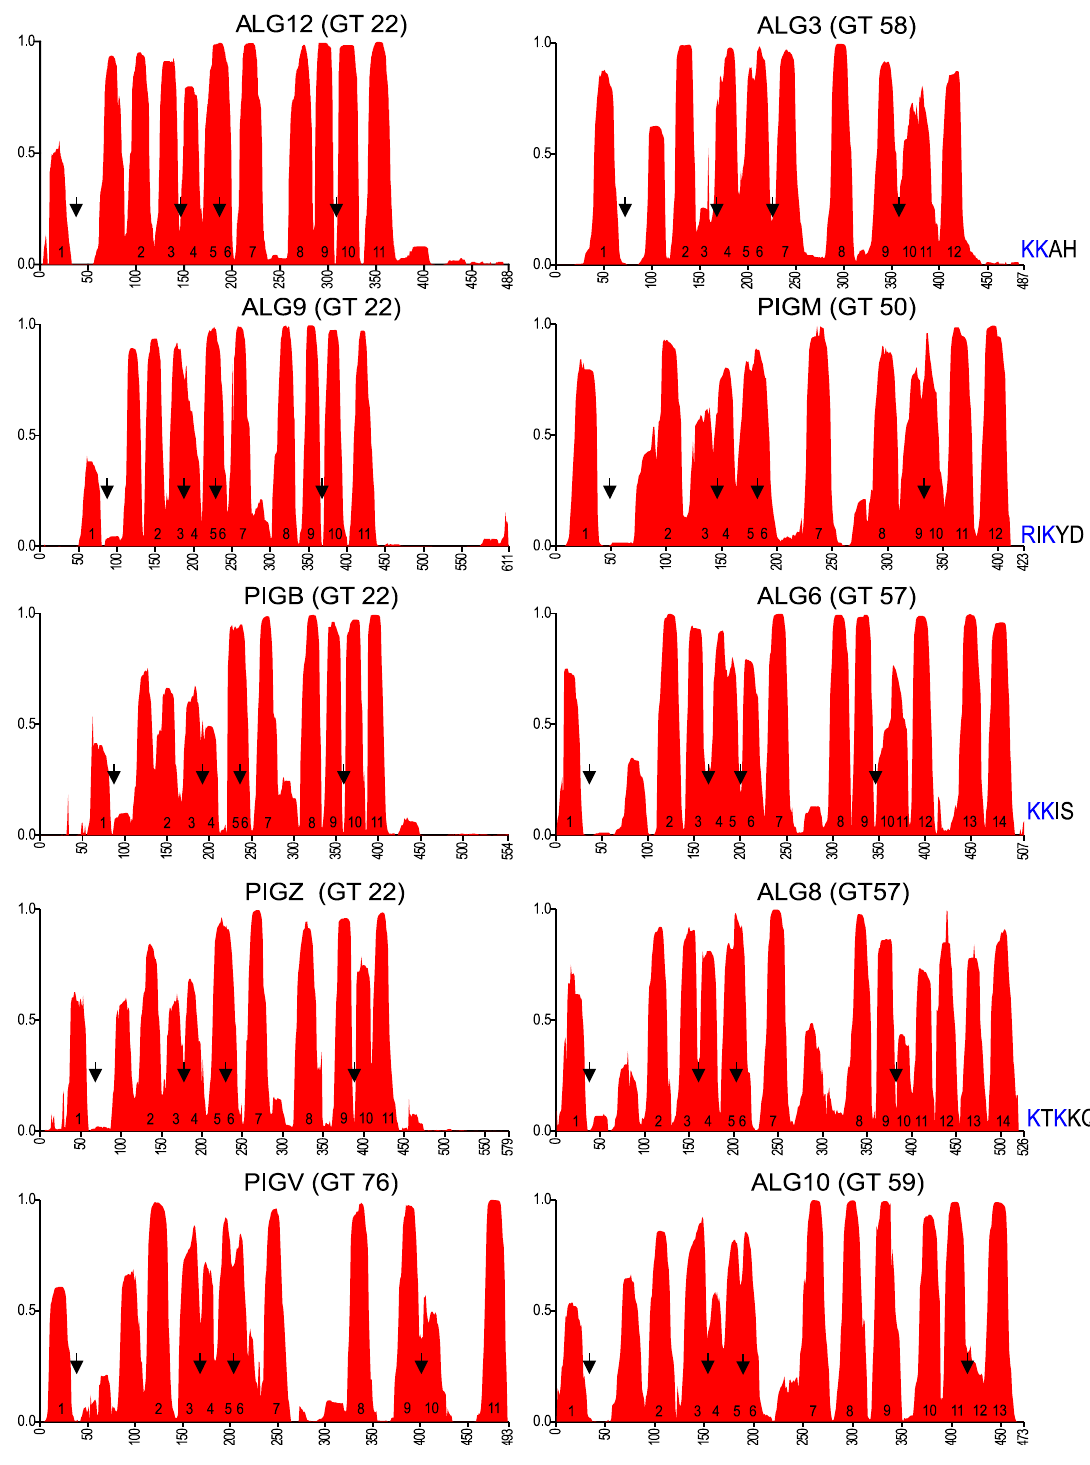
Figure 5. Membrane topology prediction of other eukaryotic glycosyltransferases of the GT-C superfamily. Arrows indicate the positions of the conserved areas that are depicted in Figure 6, corresponding to EL1, EL2, EL3, and EL5 (EL6 for ALG10, due to the two additional TMDs). The dilysine motif at the C-terminus of proteins with even numbers of predicted TMDs is shown.